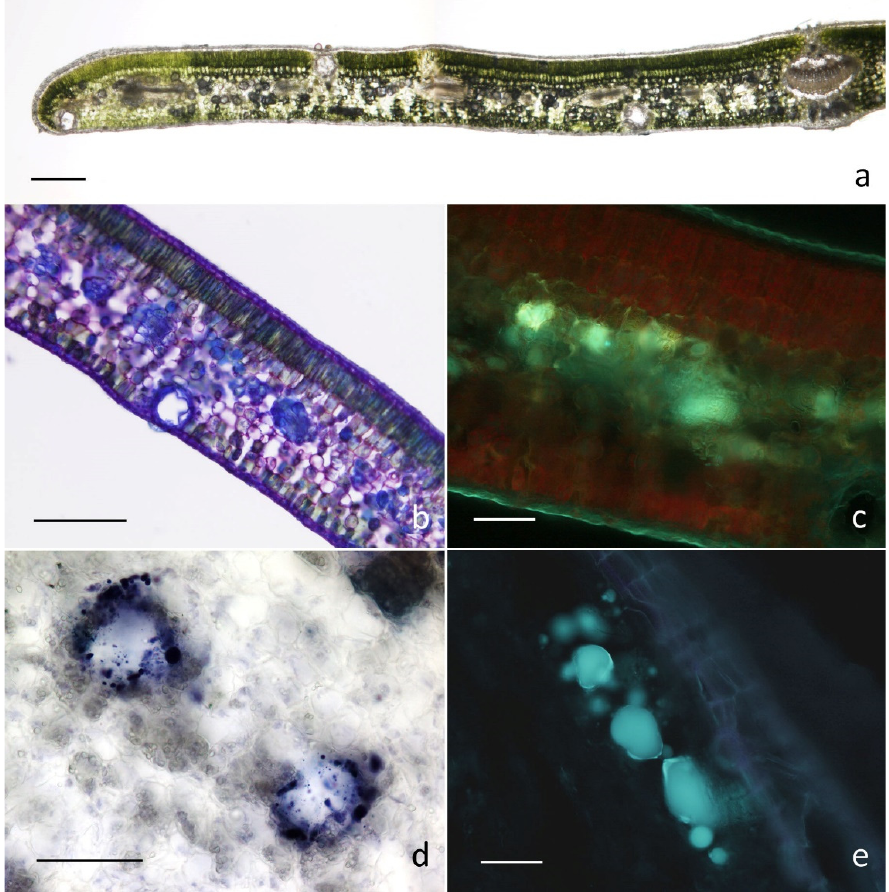
Figure 1. ( a , b ) Light microscopy images showing cross section of Myrtus communis subsp. tarentina leaf, colorless ( a ) and stained with Toluidine blue dye, ( b ). ( c – e ) Details of leaf secretory cavities, Fluoral Yellow-088 ( c ), Nadi reagent ( d ), AlCl 3 ( e ). Scale bars = 100 µ m ( a – c ); 50 µ m ( d , e )